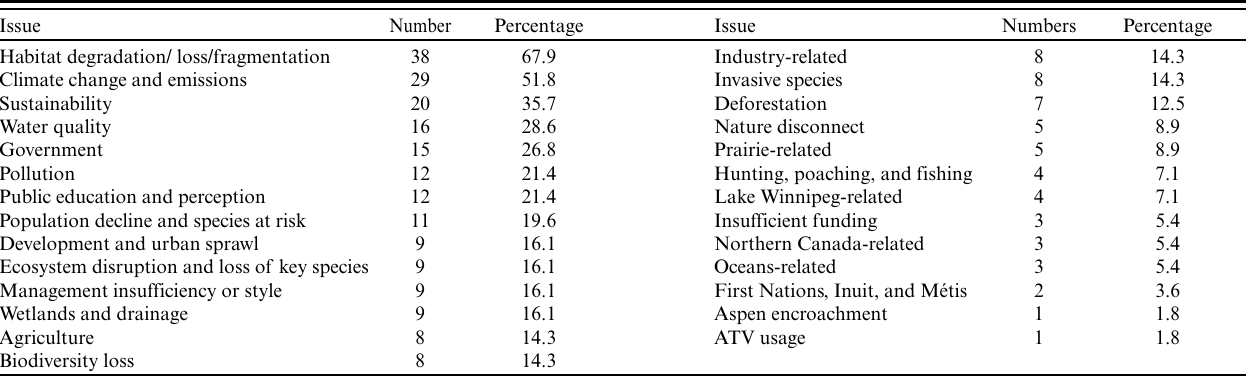
Table 2 . Nonmutually exclusive issues of environmental and conservation concern described by participants of the Manitoba Nocturnal Owl Survey in a questionnaire on participation behavior and scientific attitude distributed during November 2015–January 2016 (n =